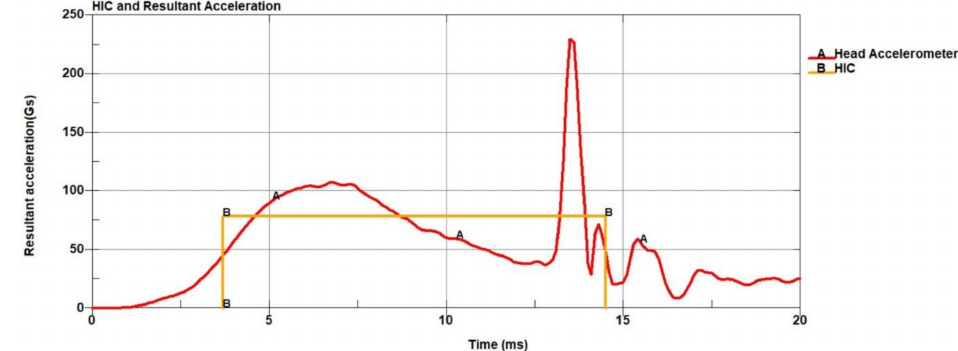
Figure A10. Course of simulation (0-20 ms, 5 ms interval) in configuration D.